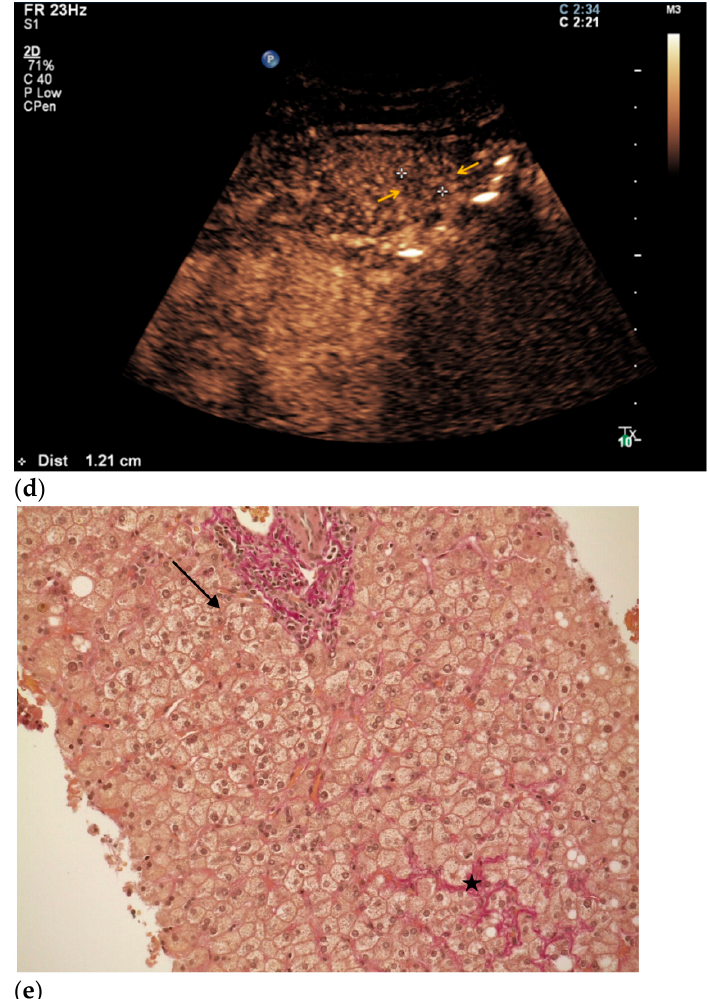
Figure 5. Sonomorphological features of a suspicious lesion in the right liver lobe. Subsequent histopathological assessment revealed liver fibrosis. ( a ) A slightly hypoechoic lesion is visualized in liver segment VI in native B-mode (yellow arrows). ( b ) The lesion appears hypervascularized in Doppler mode (yellow arrows). ( c ) In CEUS, rapid contrast enhancement was visualized in the arterial phase (yellow arrows). ( d ) The lesion showed only slight wash-out compared to the liver parenchyma in the venous phase (yellow arrows). Subsequent biopsy was performed due to the atypical sonomorphological appearance of the lesion. ( e ) Elastica van Gieson staining of the lesion, 20× magnification. Liver parenchyma with thin (black star) and broad (black arrow) fibrous septa is shown. No patterns of malignant neoplasms were detected.